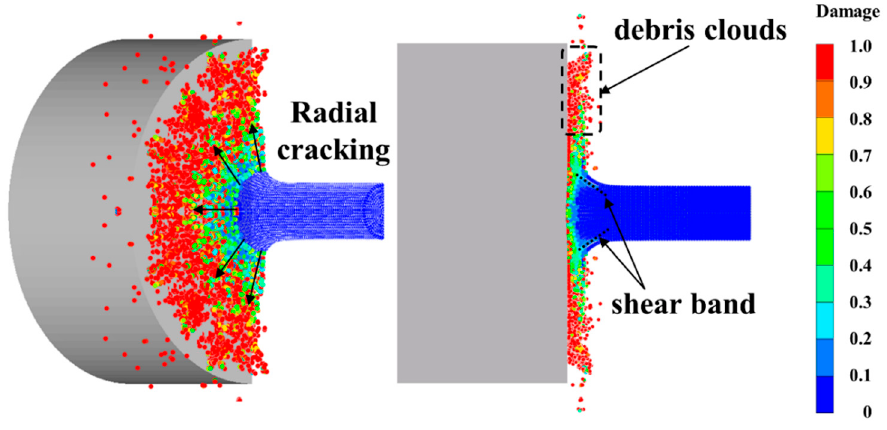
Figure 6. Simulation result of RM rod with impact velocity of 775 m/s at 30 μ s.